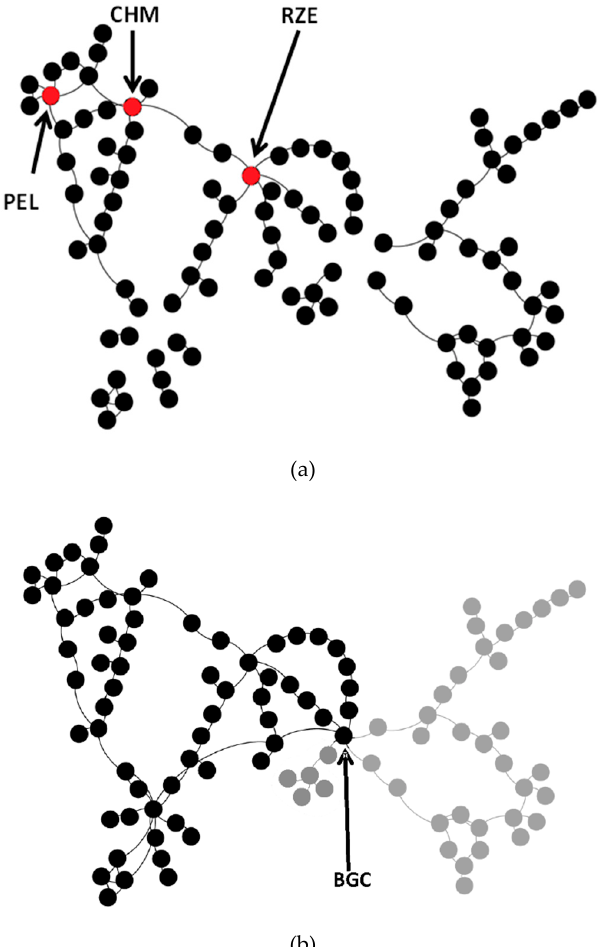
Figure 10. ( a ) The state of the graph after removing the vertices of the ninth degree and the sixth degree with the marked vertices of the fifth degree (in order from the left PEL, CHM, RZE); ( b ) after the removal of node BGC the graph is divided into two separated subgraphs.